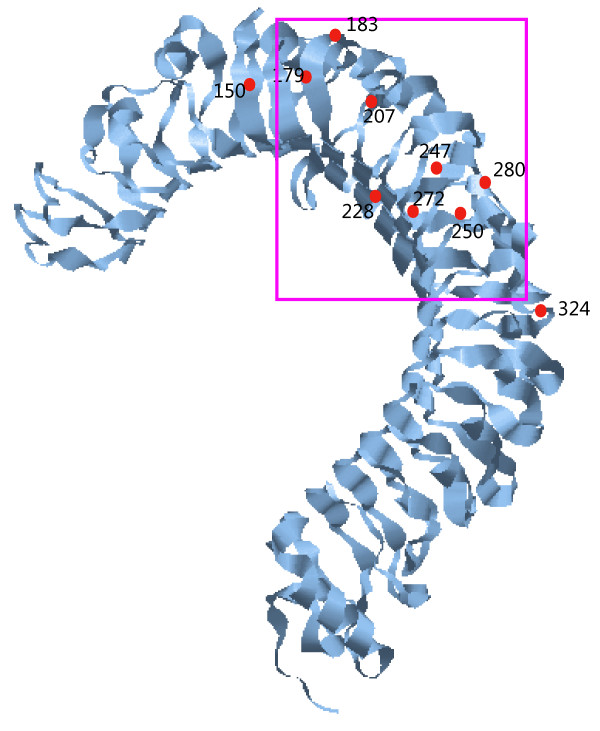
Distribution of positively selected codons in the three-dimensional structure of cetacean TLR4. The area important for ligand binding is squared in pink.